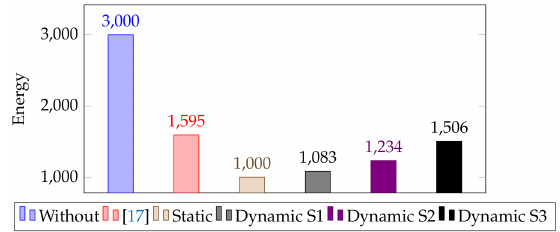
Figure 8. Energy Consumption by all nodes